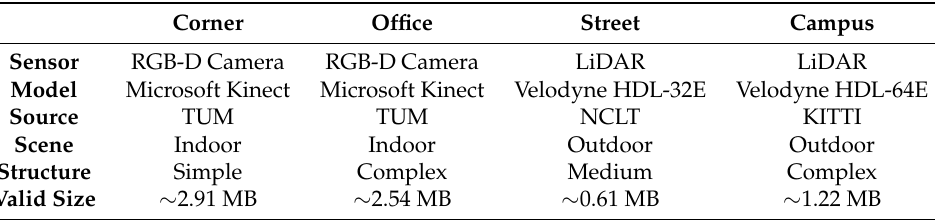
Table 1. Detailed information of the